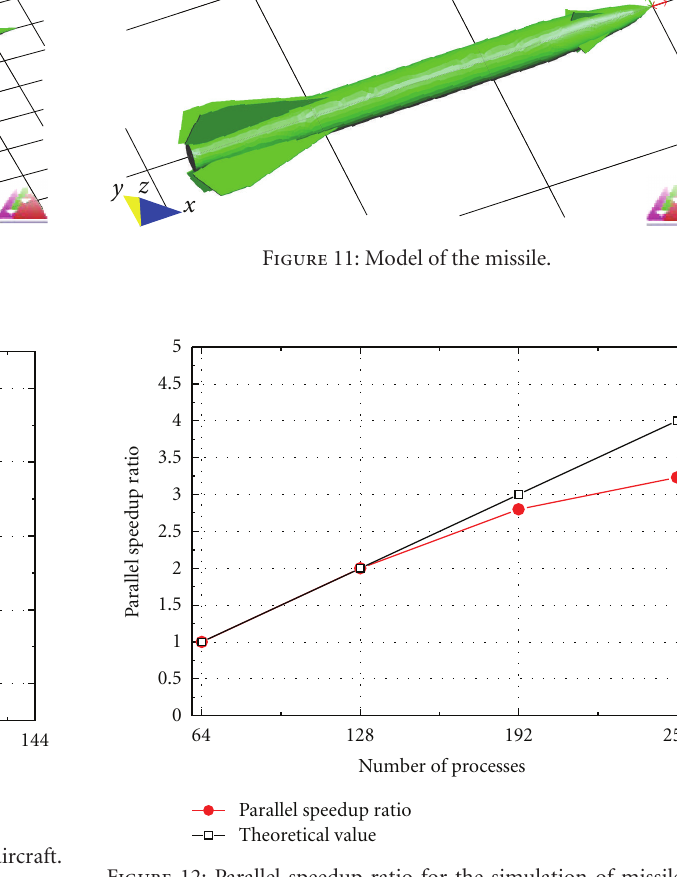
Figure 12: Parallel speedup ratio for the simulation of missile at 5GHz.